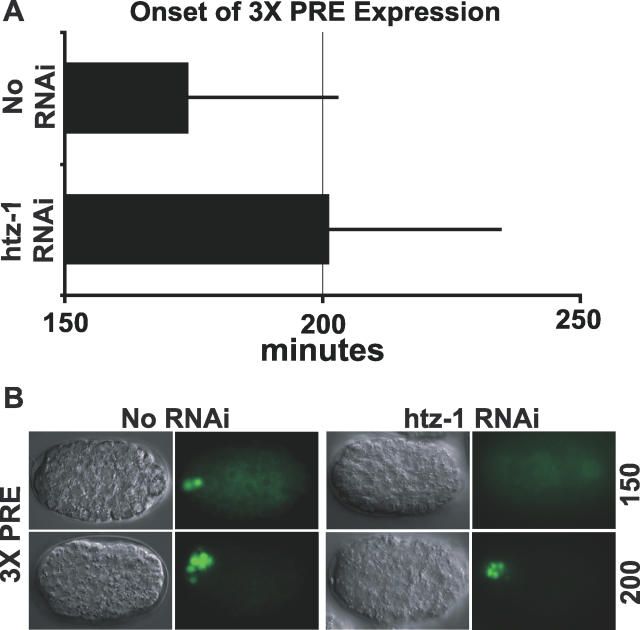

htz-1 Influences the Onset of Early PHA-4–Dependent Expression(A) Onset of 3XPRE::GFP after the two-cell stage for wild-type (black) or htz-1(RNAi) (grey) embryos. 3XPRE::GFP is a reporter construct with three copies of a high-affinity PHA-4 response element upstream of the Δpes-10 promoter that reproducibly activates early pharyngeal expression [19]. Activation of the 3XPRE::GFP reporter is delayed after injection of htz-1 dsRNA (p = 0.0289, Student t-test). No RNAi: n = 23, htz-1 RNAi: n = 9 embryos. Error bars indicate the standard deviation.(B) Expression of 3XPRE::GFP at 150 and 200 min after the two-cell stage with htz-1 RNAi or without (No RNAi).